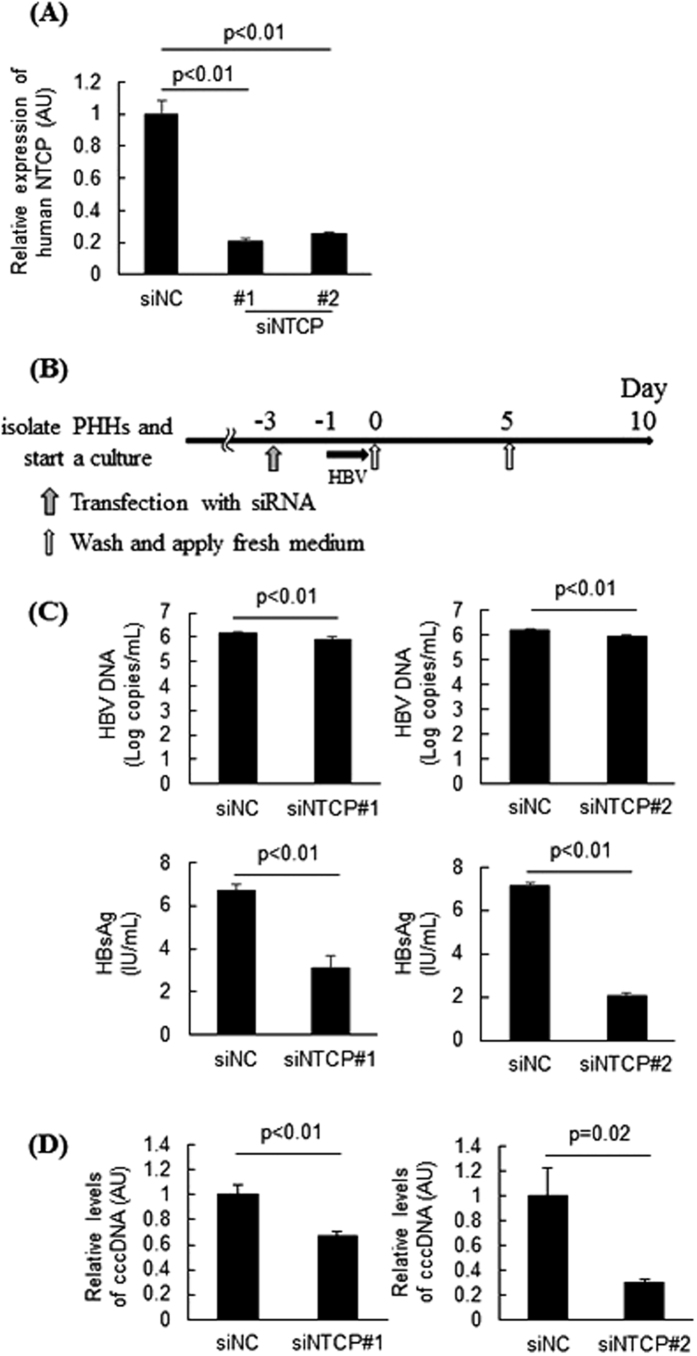
NTCP inhibition decreased susceptibility to HBV.(A) PHHs were transfected with specific siRNA against human NTCP. We used two siRNA sequences (siNTCP#1 and siNTCP#2), which target different amino acid sequences within human NTCP. Human NTCP expression levels were determined at 3 days post-transfection (n = 4). (B–D) PHHs were inoculated with HBV 3 days after transfection with siRNA against NTCP. Schematic of experimental procedure (B). HBV DNA and HBsAg levels in the culture medium at 10 days post-inoculation (n = 4) (C). cccDNA levels in PHHs at 10 days post-inoculation (n = 4) (D). AU; arbitrary unit.